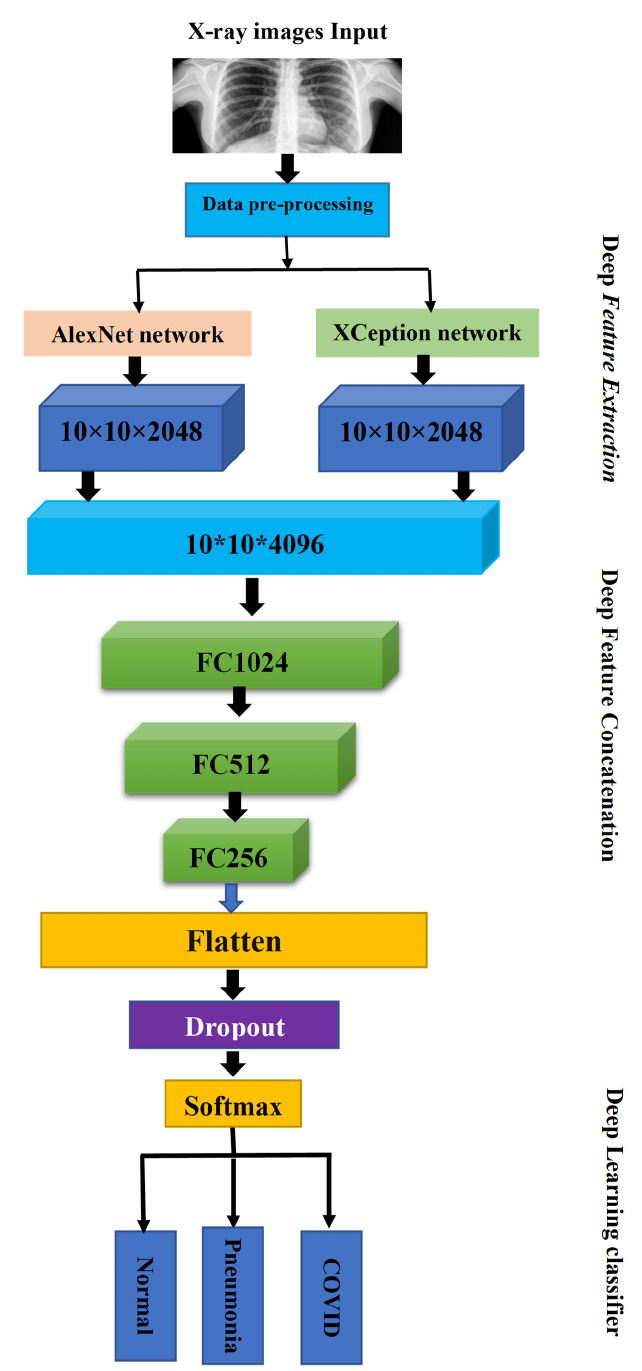
Figure 5. Graphical abstract of proposed method.